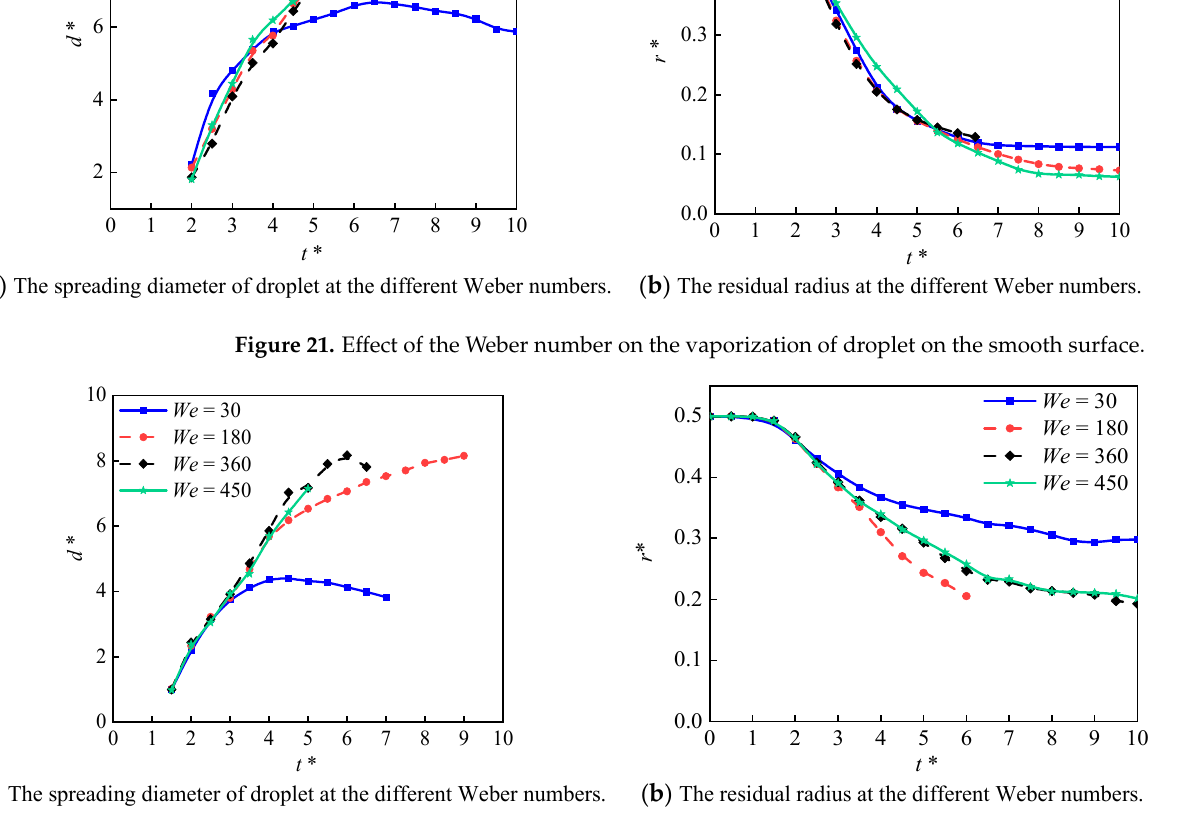
Figure 22. Effect of the Weber number on droplet vaporization on the micro-structured surface.